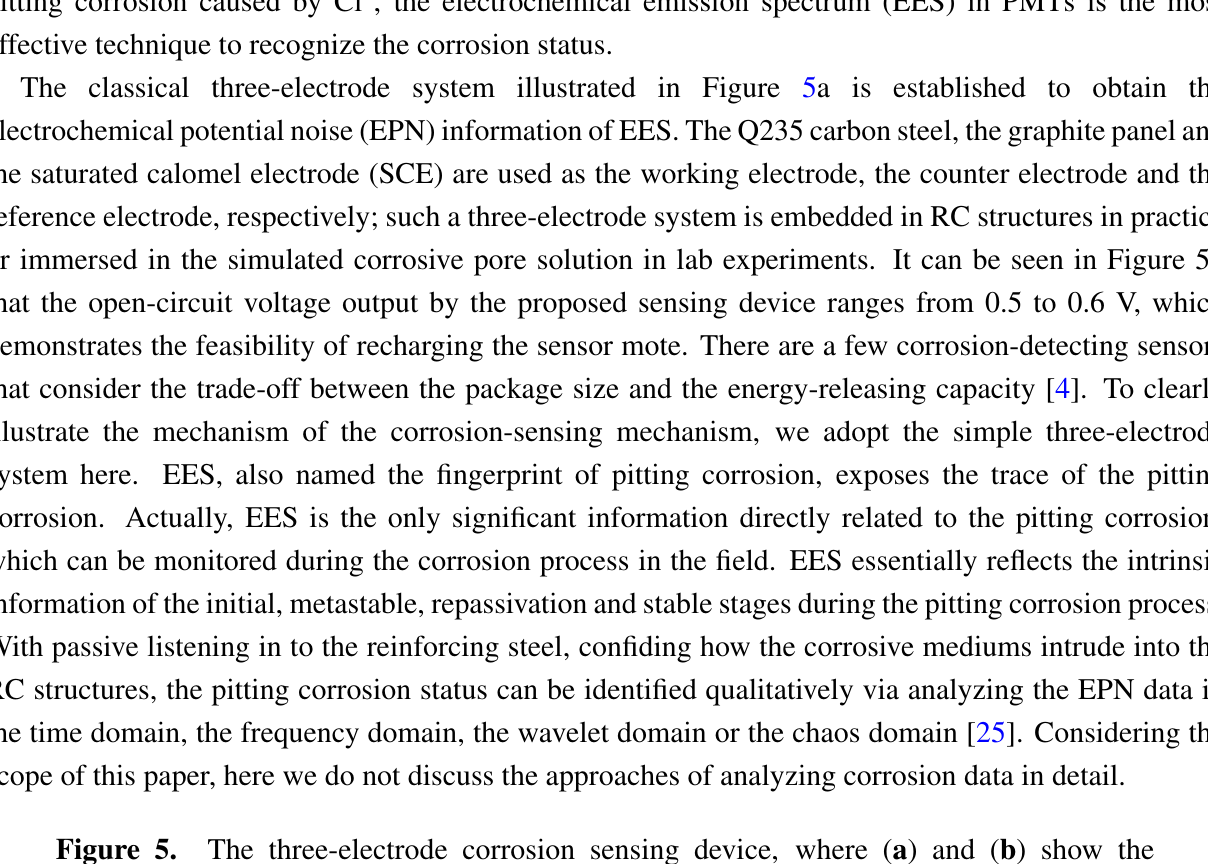
schema and the open-circuit output voltage of the device, respectively. calomel